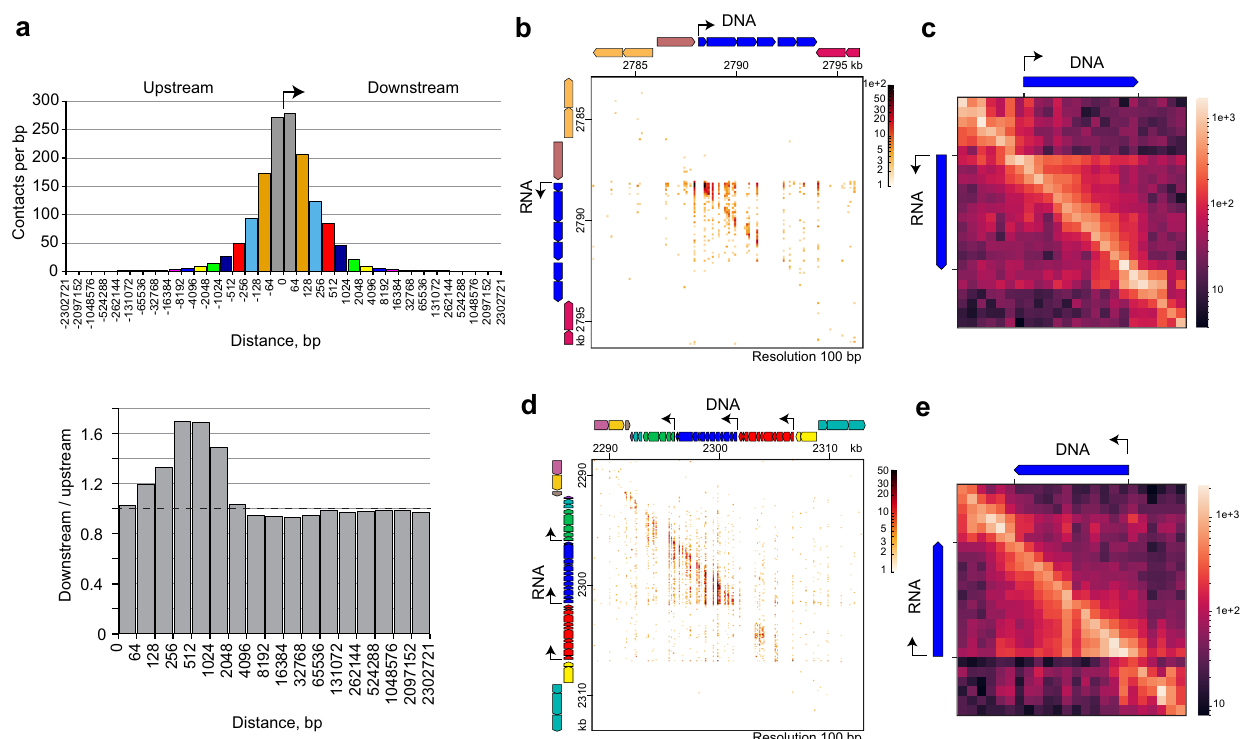
Fig. 2 Contacts of mRNA with encoding genes and neighboring areas in E. coli . a Frequency of contacts of mRNA fragments in intervals upstream and downstream of the encoding DNA segment. Pairs of bars of the same color represent equally spaced intervals downstream and upstream of the encoding DNA segment. Shown below is the ratio of contact frequencies between equally spaced intervals. b RNA – DNA contact map for a region of E. coli genome harboring operon rbsDACBKR transcribed in the sense direction (colored in blue). c Cumulative contact map for all operons of protein-coding genes of E. coli transcribed in the sense direction ( n = 267). d RNA – DNA contact map for a region of E. coli genome harboring ribosomal protein operons rpsMKD-rpoA- rplQ (green), spc (blue), and S10 (red) transcribed in the antisense direction. e Cumulative contact map for all operons of protein-coding genes of E. coli transcribed in the antisense direction ( n = 311). Note that a vertical streaked pattern in contact maps in ( b ) and ( d ) is due to the absence of NlaIII sites in many genomic bins at the used map resolution (100